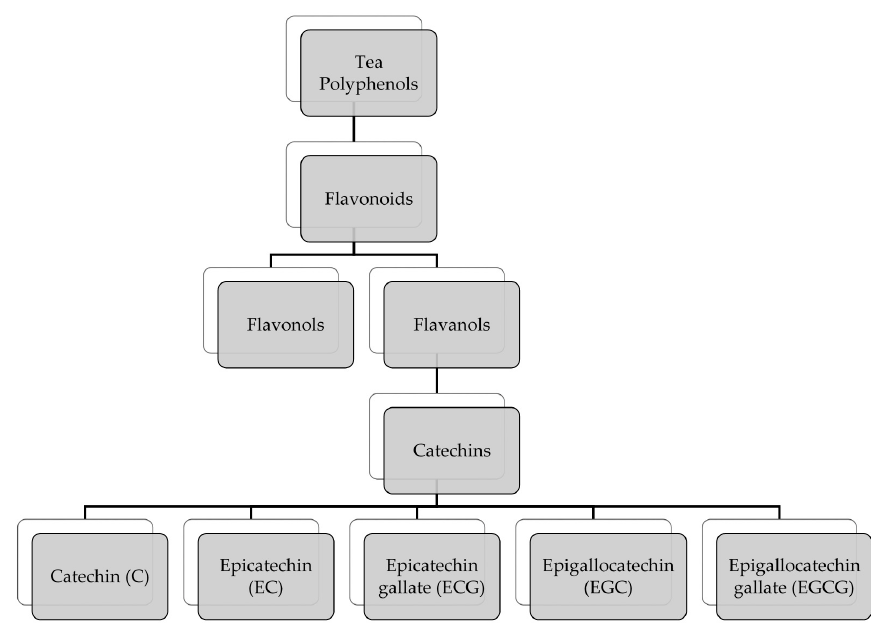
Figure 1. Major components of the tea polyphenol family.